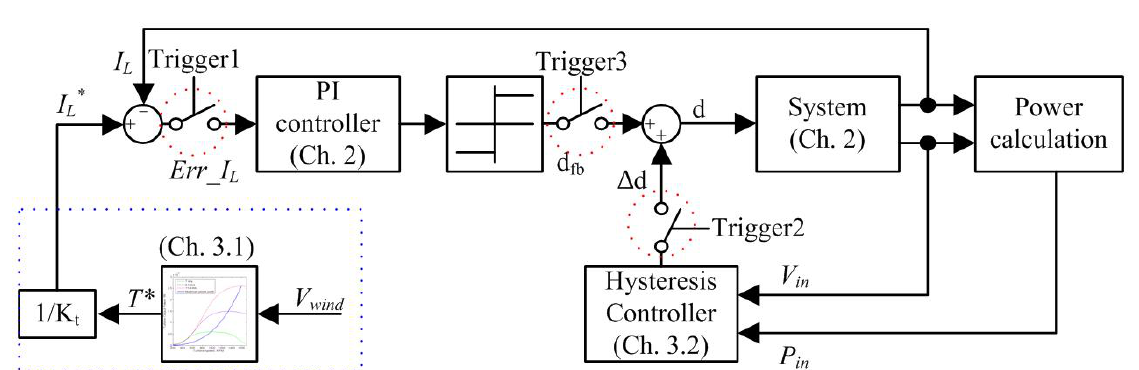
Figure 9. Flow chart of the proposed MPPT